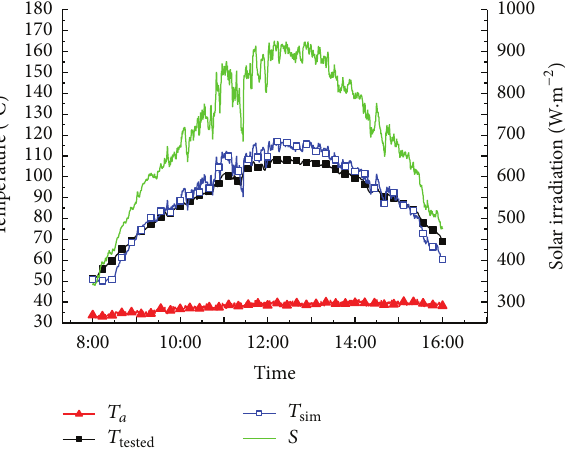
Figure 8: Testing results on July 22, 2014, where 𝑇 𝑎 , 𝑇 tested , 𝑇 sim are the ambient temperature and tested and simulated temperature of the TPET surface, respectively, and 𝑆 is the solar